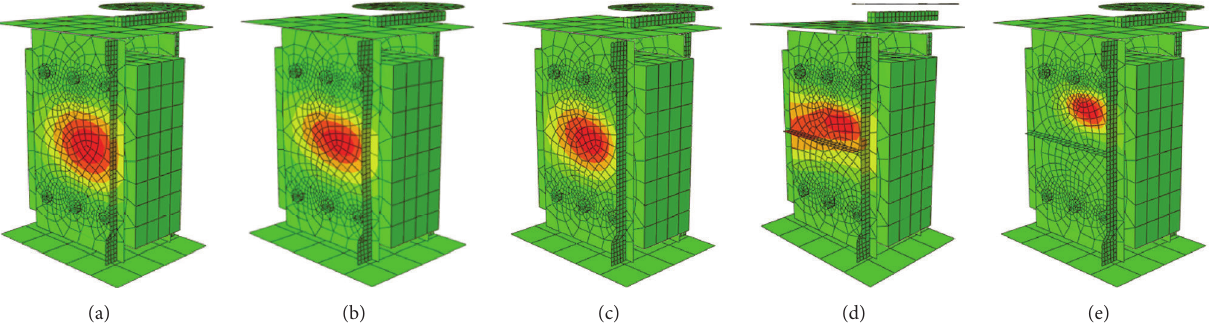
Figure 9: Failure modes of models with arranging different stiffeners: (a) E4SN, (b) E4MN, (c) E6LN, (d) E4MM, and (e) E4LL.